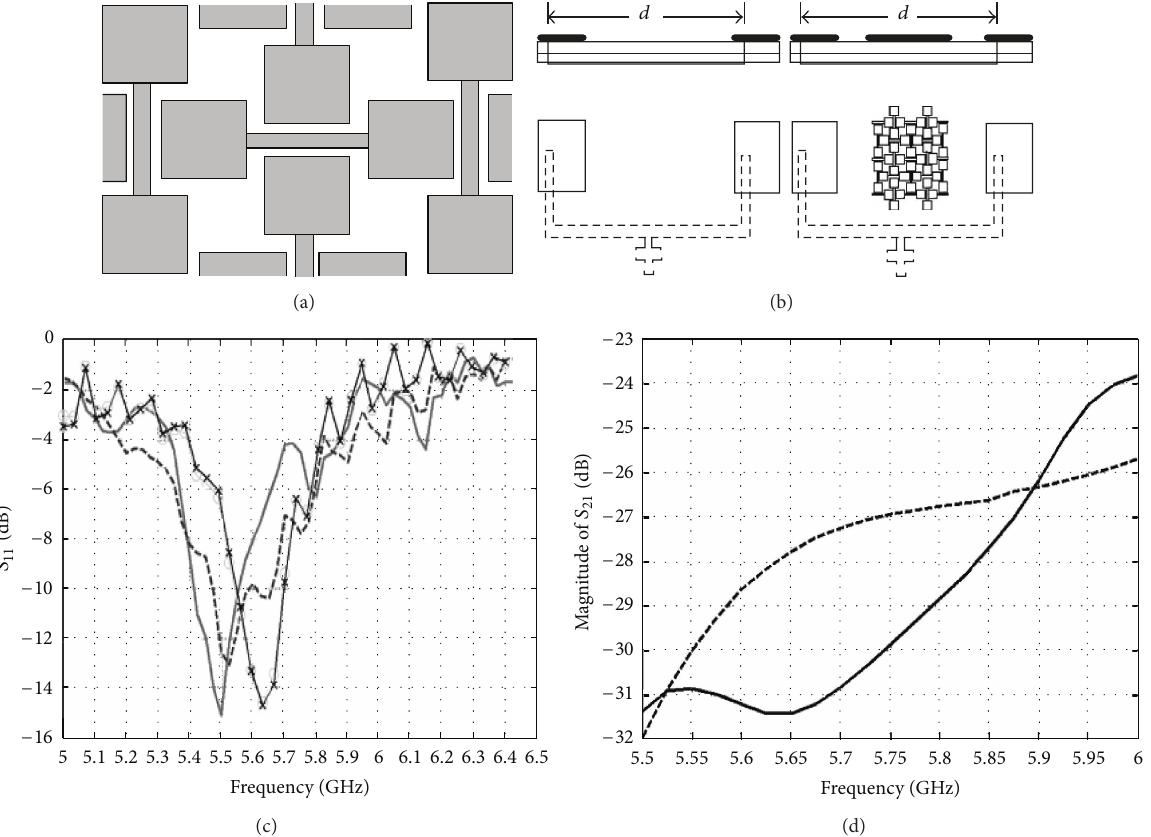
Figure 24: (a) DEBG structure, (b) MSAA with and without DEBG, (c) 𝑆 11 comparison, solid line: measured without EBG, dashed line: measured with EBG, and cross mark line: simulated with EBG, and (d) 𝑆 21 comparison, dashed line: without EBG, solid line: with EBG.